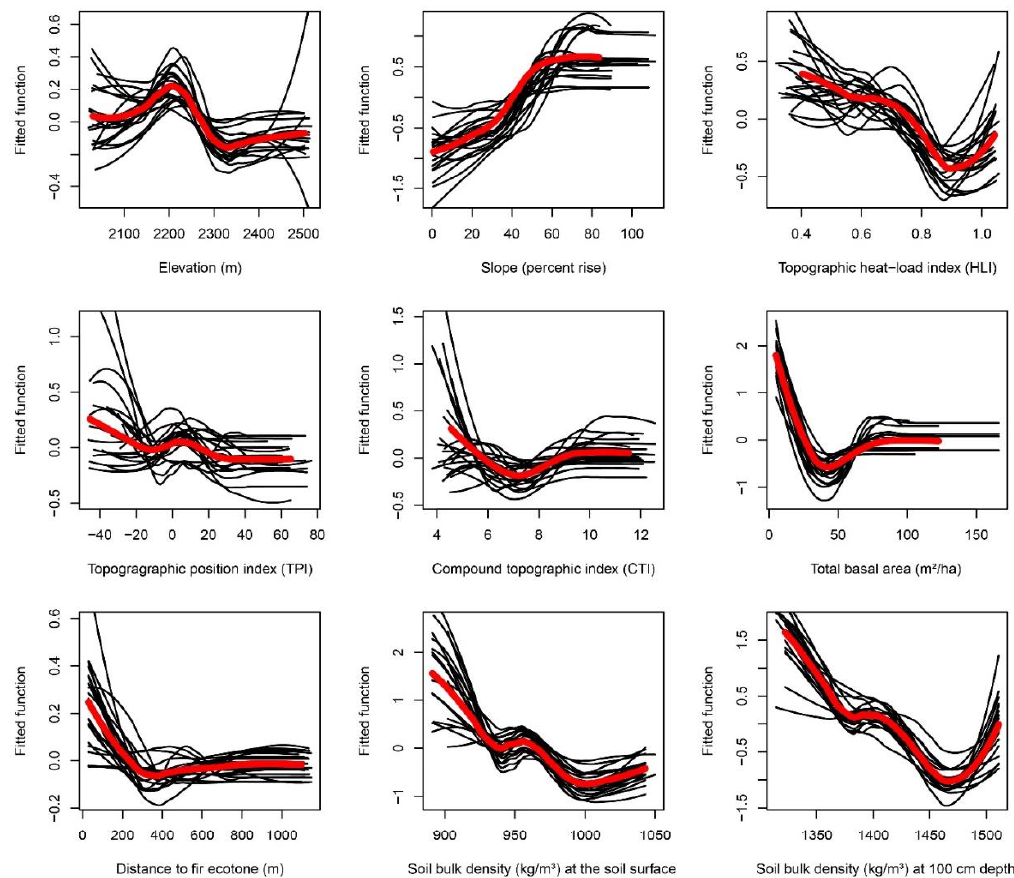
Figure A5. Partial-dependence plots from boosted regression tree models of refugia from drought and mountain pine beetle impacts in lodgepole pine areas in 2009. Black lines represent loess-smoothed partial-dependence relationships from 20 independent bootstrapped model runs using a random subsample of n = 2000 grid cells for each model run. Red lines indicate means across 20 bootstrapped model runs. In all plots, higher values on the vertical axis represent greater prevalence of refugia.